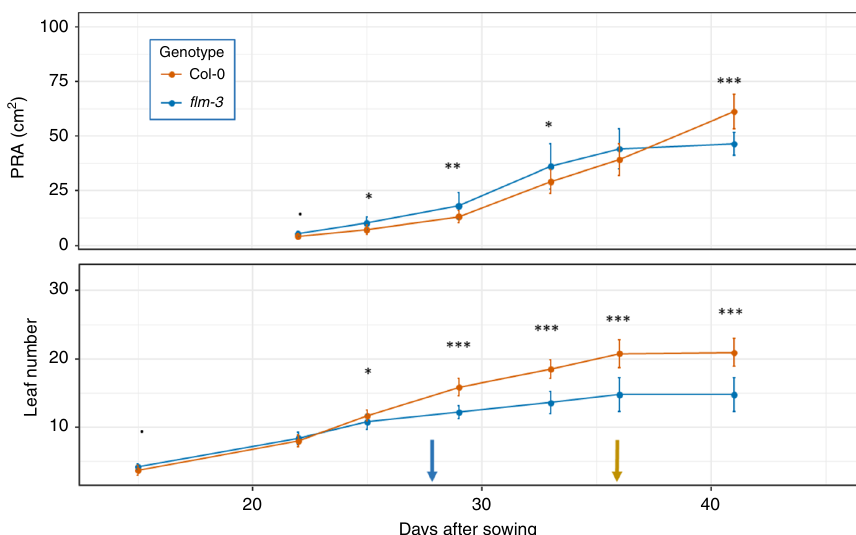
Fig. 3 Relationships between vegetative growth and bolting time according to the FLM allele. Dynamics of projected rosette area (PRA) and leaf number followed until 41 days after sowing. Brown and blue arrow indicate the bolting time ( fl oral stem 1 cm) in fl m-3 and Col-0 respectively. For each genotype, n = 12 individual plants. Data are presented as mean values ± s.d. Source data are provided as a Source Data fi